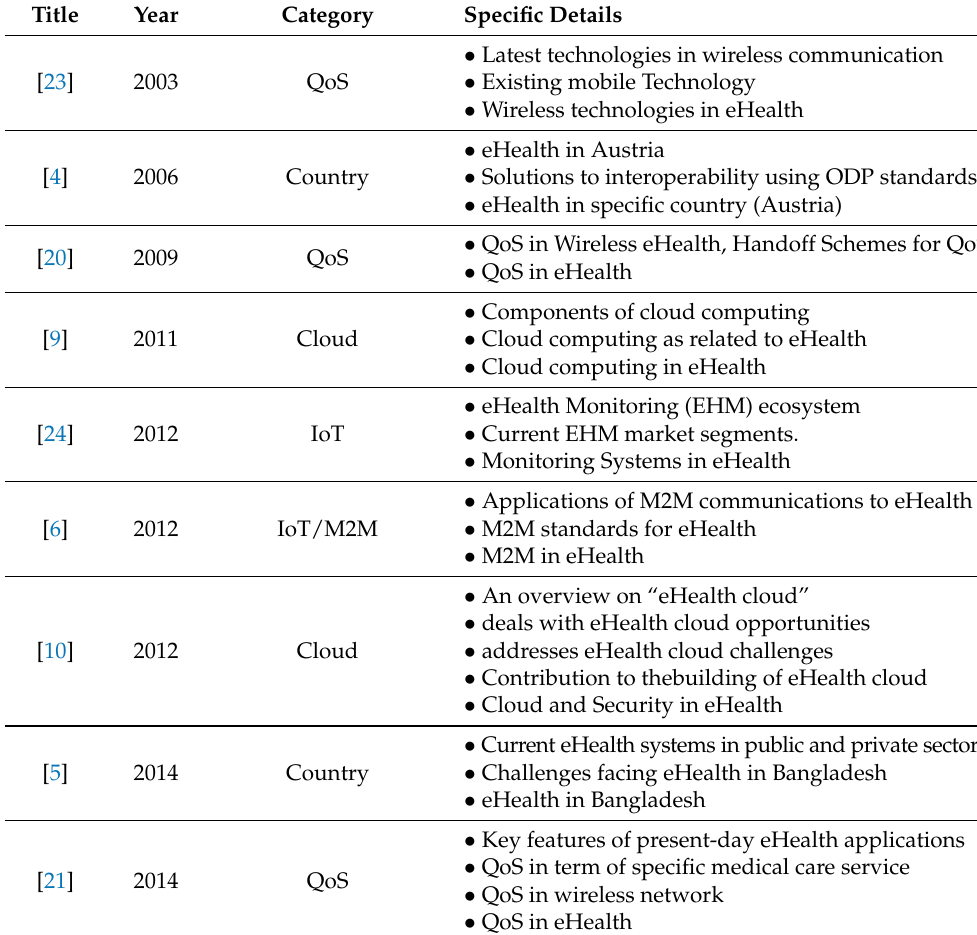
Table 1. Summary of the related